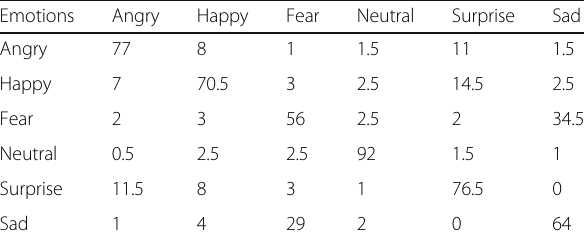
Table 3 Confusion degree between angry, happy, and